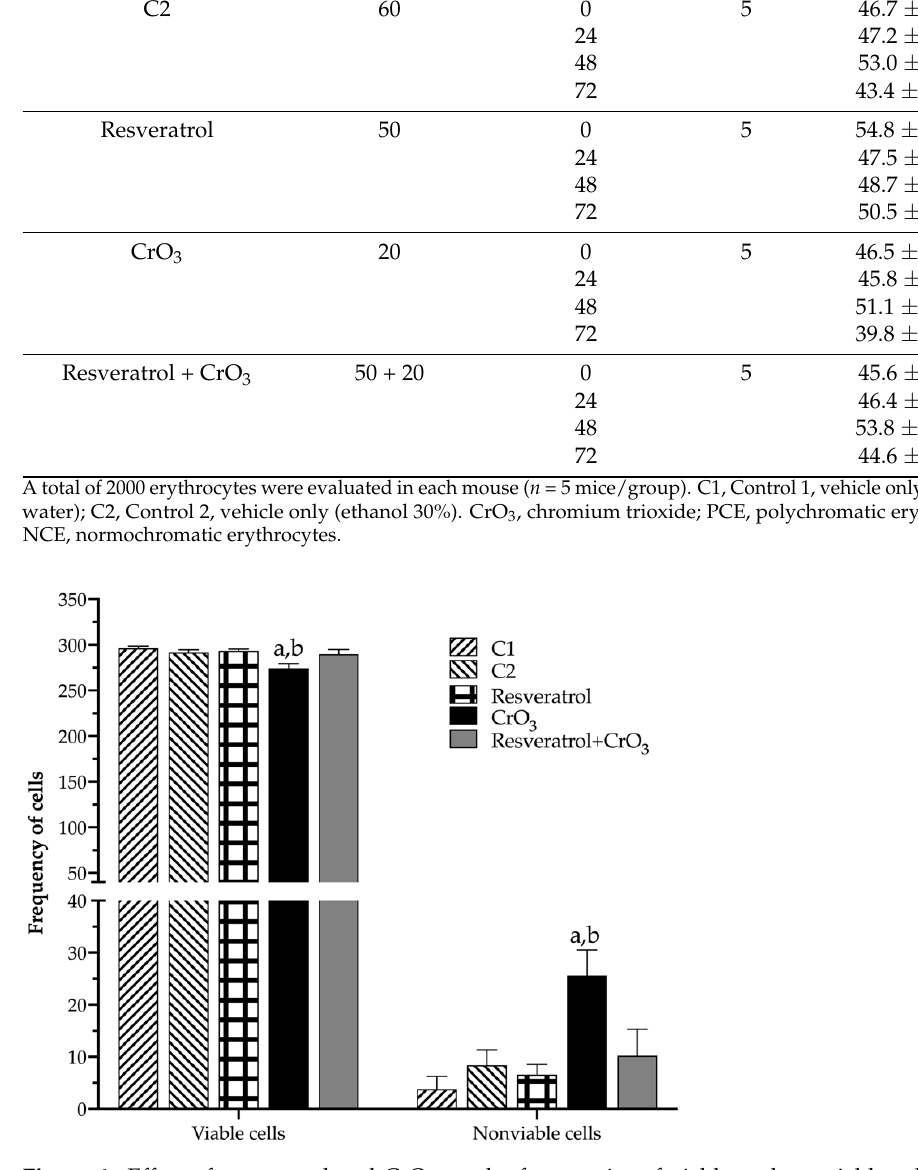
Treatment Dose (mg/kg)